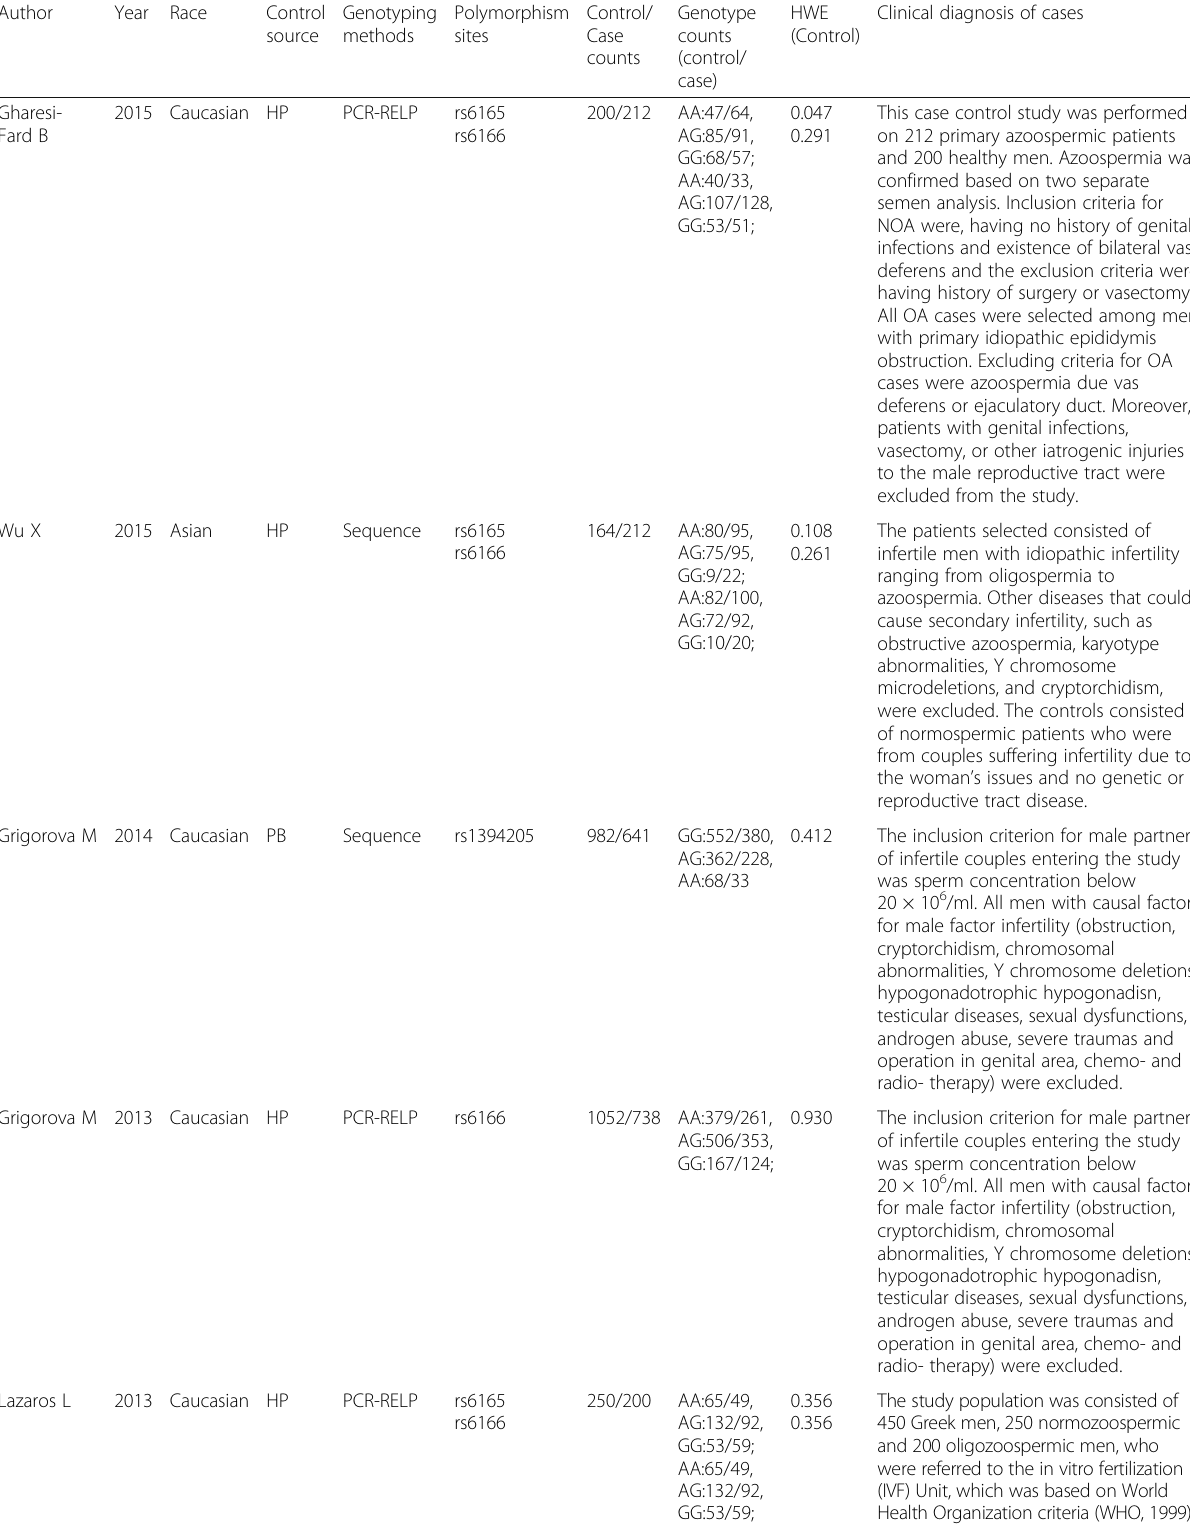
Table 4 Main characteristics of all studies on the genotype of FSHR rs6165, rs6166 and rs1394205 included in the meta-analysis